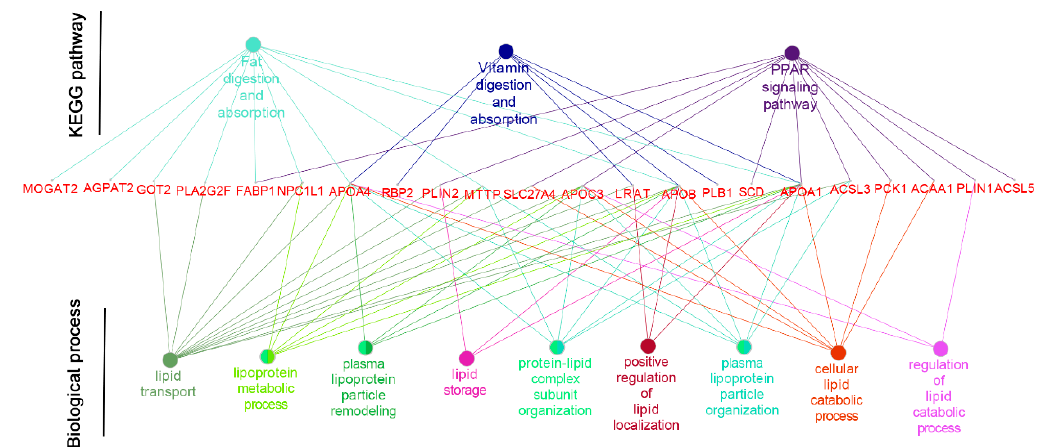
Figure 3. Genetic network and functions of PSGs (positively selected genes) related with the KEGG pathway of the PPAR signaling pathway, fat digestion and absorption, vitamin digestion and absorption. Functions were defined using Gene Ontology (GO) and the Kyoto Encyclopedia of Genes and Genomes (KEGG) annotations and the network was constructed by ClueGO and the CluePeidia plugin in Cytoscape. Each solid circle represents a gene or a functional category, the colored line show ontology relations. APOA1: Apolipoprotein A1; APOA4: Apolipoprotein A4; APOB: Apolipoprotein B; AGPAT2: